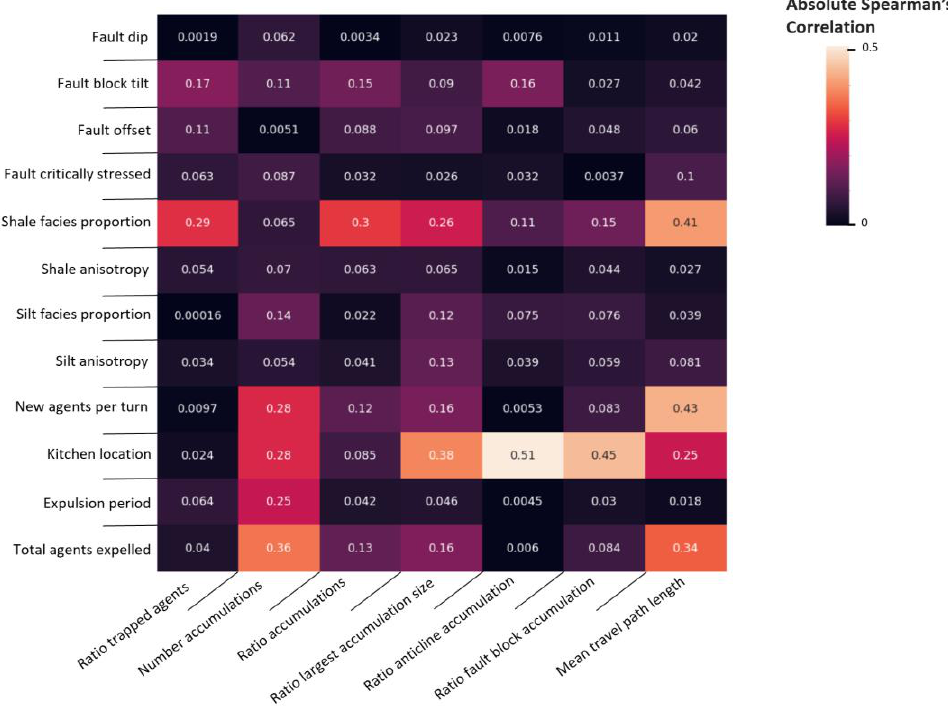
Figure 8. Spearman correlation matrix showing the correlation of the geological uncertainties with the evaluation metrics.